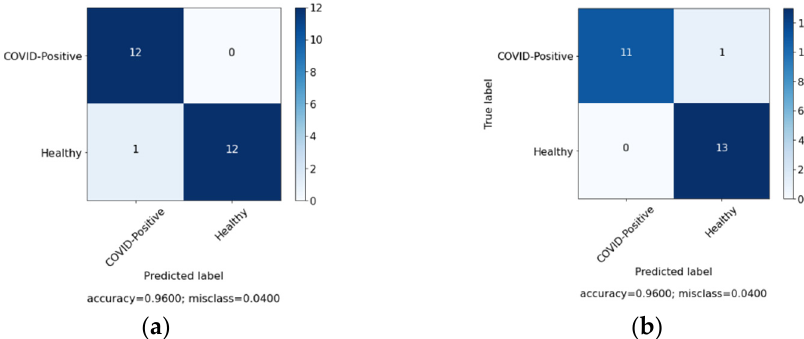
Figure 11. Diagnosis comparison for case 3 (fusion). ( a ) Expert diagnosis. ( b ) System diagnosis. Table 6. Diagnosis comparison among the doctor and the system for the three different cases.